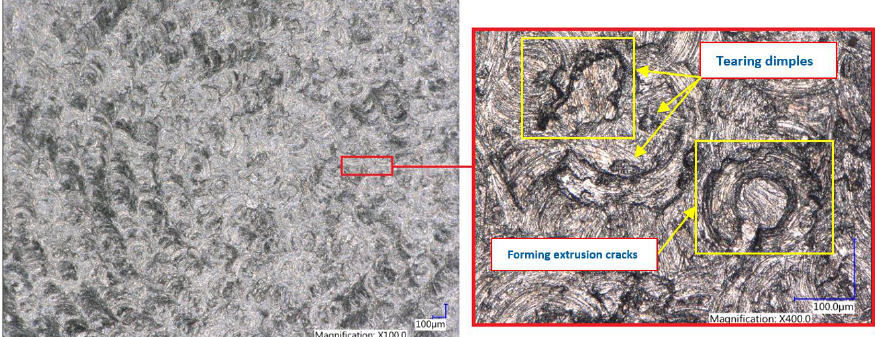
Figure 31. Display of the plowing effect with surface defects in spiral strategy.